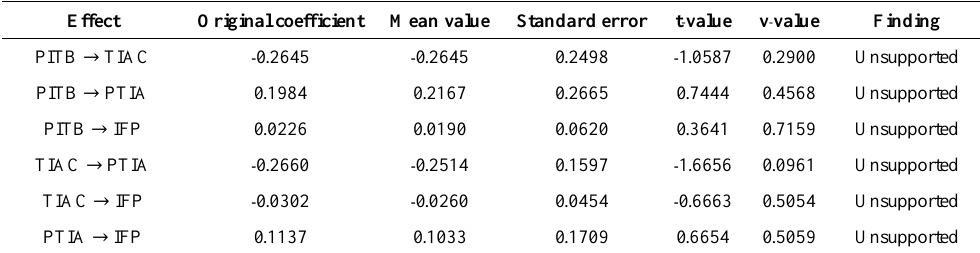
Table 3. Structural equation modeling